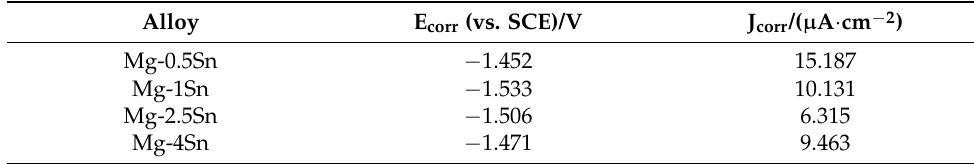
Figure 4. ( a ) Polarization curves in 3.5 wt.% NaCl solution of the Mg- x Sn. ( b ) Weight loss rates of the Mg- x Sn alloys after immersion in a 3.5% NaCl solution for 110 h. Table 2. Fitting results of polarization curves.